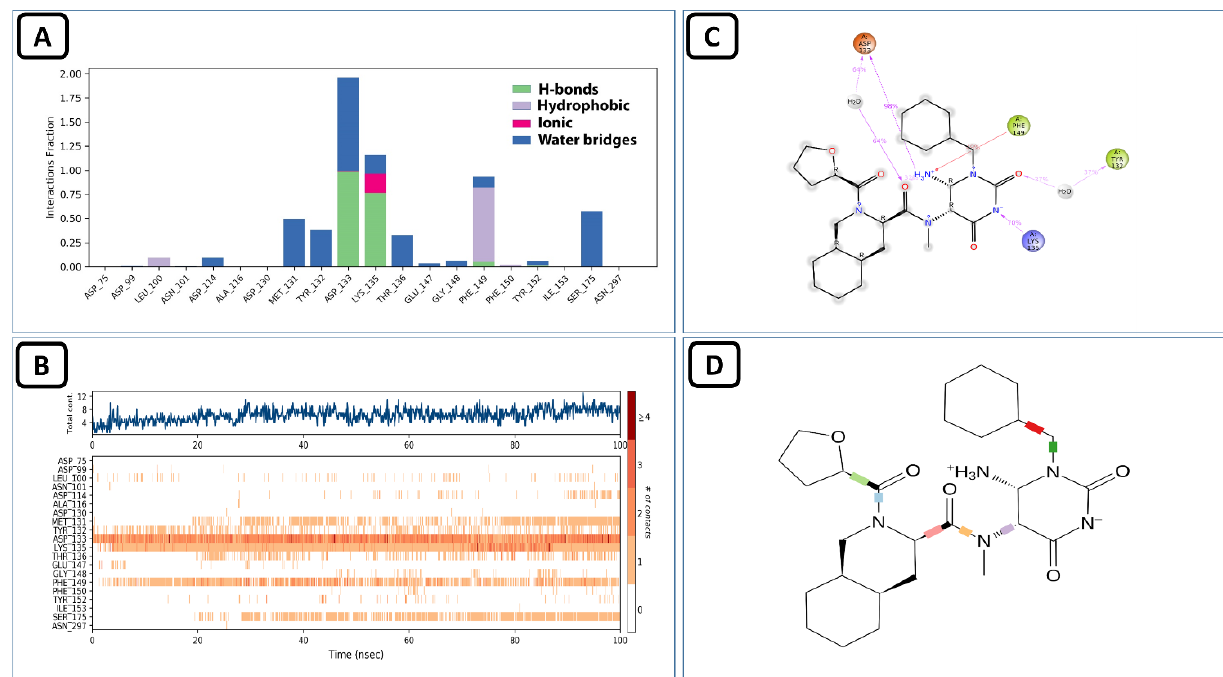
Figure 13. ( A ) Shows the protein-ligand interaction types, ( B ) shows the intensity of interactions, ( C ) shows individual residues engaged by this ligand during the 100 ns simulation, and ( D ) shows the ligand’s rotatable bonds or ligand